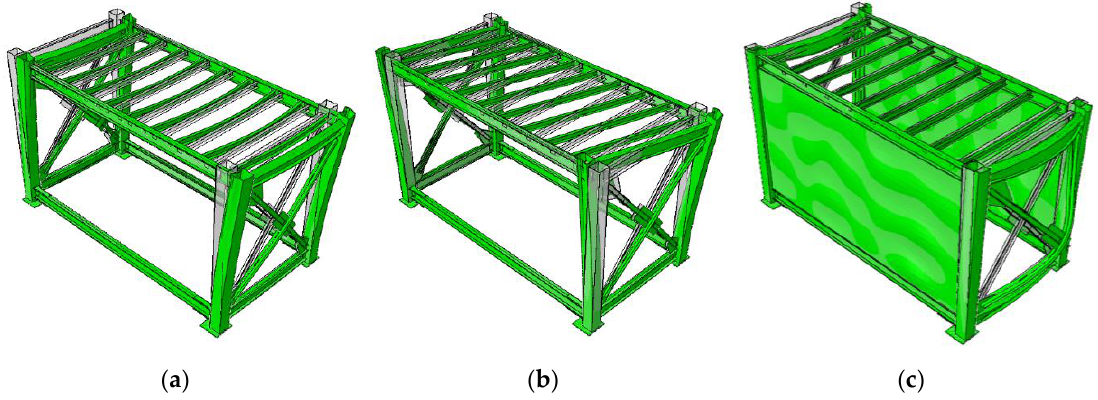
Figure 13. Fundamental natural vibration modes of ( a ) bare module, 1st at 6.6Hz; ( b ) bare module, 2nd at 8.0Hz; ( c ) coupled module-wall system, 1st at 18.5 Hz.